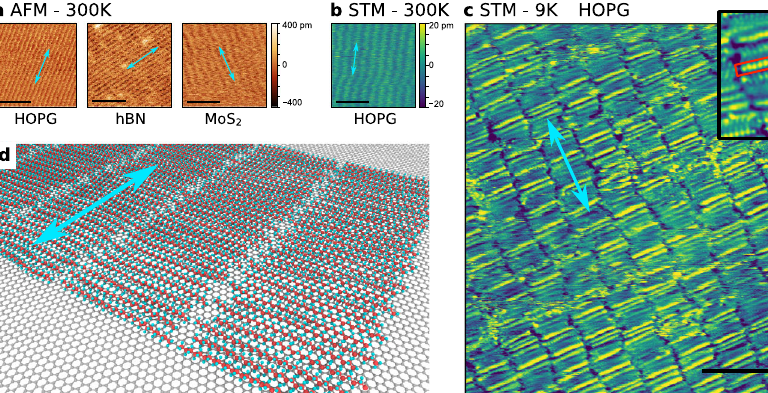
Fig. 1 | Stripe patterns on vdW materials, due to ambient contamination. a PeakForce QNM topography maps measured on the surface of bulk HOPG, hBN, and MoS 2 crystal terraces showing parallel stripes (Scale bars: 30nm). b Room- temperature STM topography showing the smectic phase of the monolayer (Scale bar: 20nm). c Low-temperature (9K) STM topography map showing the inner structure of the stripes: the single molecular building blocks and the superlattice